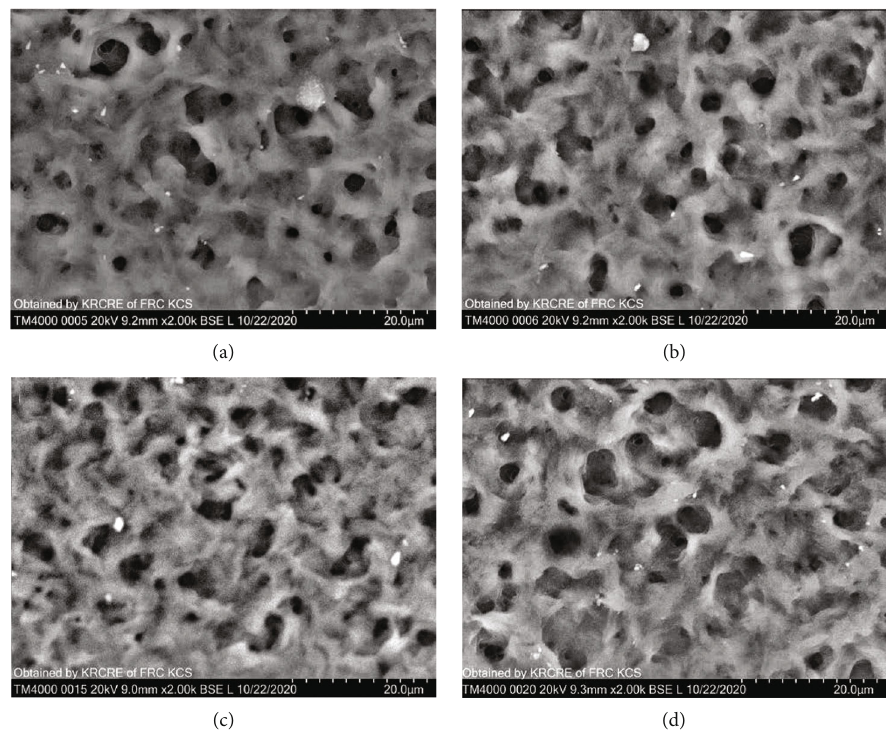
Figure 3: SEM (TM4100 (Hitachi, Japan)) images of PHBV and OZ-PHBV fi lms. (a) PHBV-F; (b) OZ-F, 0.008% of OZ; (c) OZ-F, 0.016% of OZ; (d) OZ-F, 0.024% of